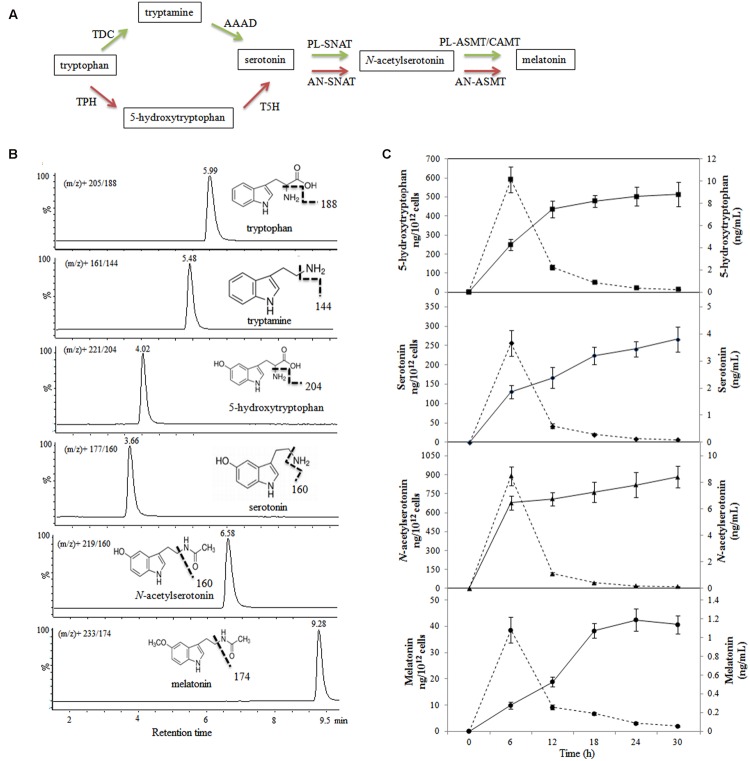
Evolution of metabolite production in melatonin biosynthesis pathway in Bacillus amyloliquefaciens SB-9. (A) Melatonin biosynthesis pathway in animals and plants. Red arrows indicate the animal pathway, and green arrows indicate the plant pathway. TPH, tryptophan hydroxylase; AAAD, aromatic amino acid decarboxylase; TDC, tryptophan decarboxylase; T5H, tryptamine 5-hydroxylase; AN-SNAT, animal serotonin N-acetyltransferase; PL-SNAT, plant serotonin N-acetyltransferase; AN-ASMT, animal N-acetylserotonin O-methyltransferase; PL-ASMT, plant N-acetylserotonin O-methyltransferase; CAMT, caffeic acid O-methyltransferase. (B) Chemical structures and UPLC-MS/MS chromatograms of five standards (40–60 ng/mL). (C) Levels of metabolites involved in the melatonin biosynthesis in a B. amyloliquefaciens SB-9 culture grown in medium containing 200 mg/L tryptophan. The levels are expressed as ng/mL (solid line) and ng/1012 cells (dotted line), and the data points represent the means ± SD (n = 3).